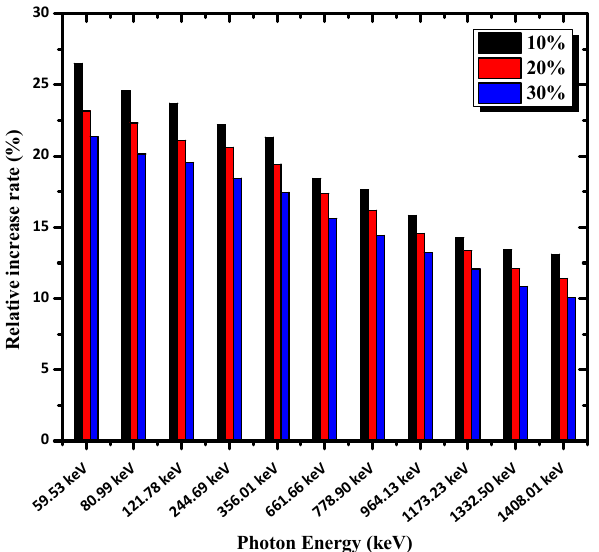
high filler loadings.